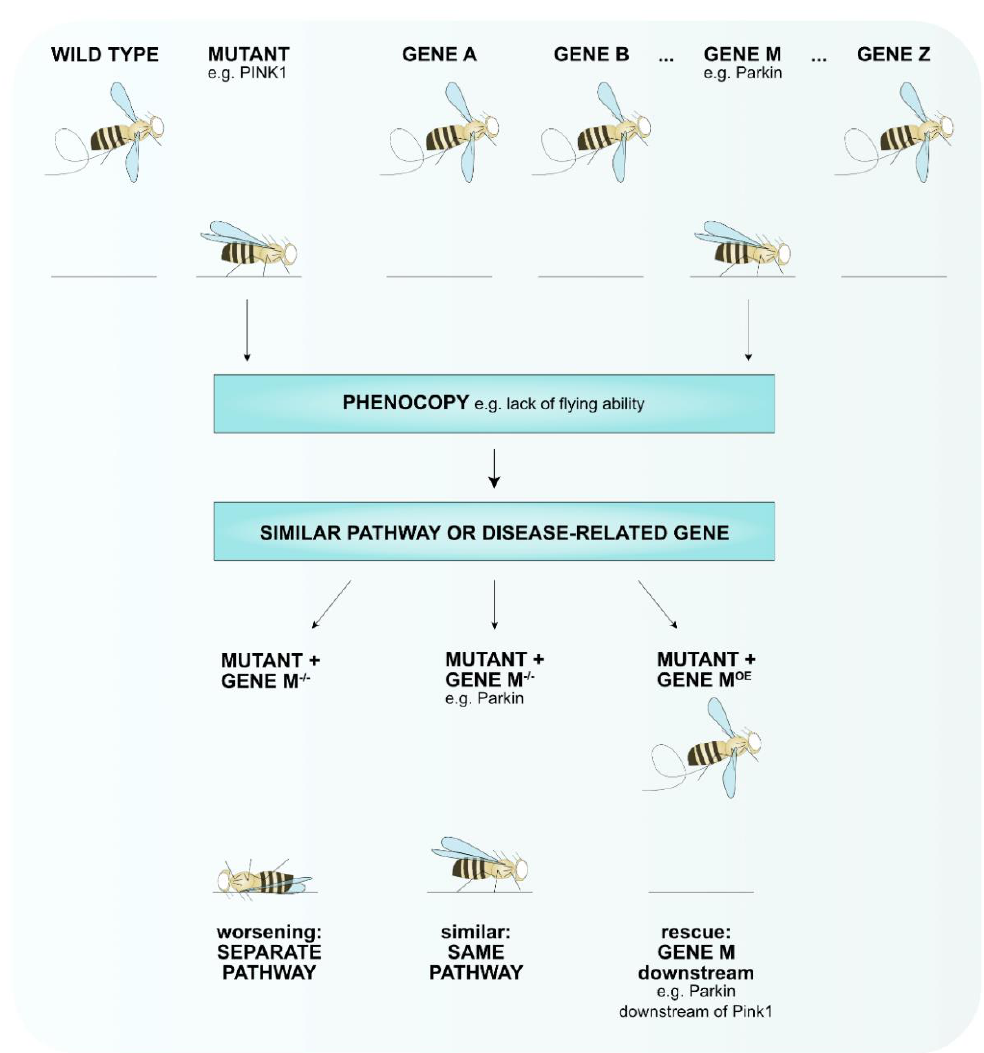
Figure 1. A phenotypic screen can identify novel genes involved in the disease pathway. A collection of mutant alleles (gene A–gene Z) can be used to identify genes that when mutated result in the same phenotype (phenocopy) e.g., lack of flying ability for pink1-mutant flies that are mimicked by parkin-mutant flies. To test if these genes function in the same pathway, the phenotypes of double-mutant flies can be tested. Loss of gene M worsens the phenotype of the disease mutant, thus, separate pathways play a role that converge into one. Loss of gene M does not enhance or improve the phenotype of the mutant meaning that these genes function in the same pathway (e.g., Pink1-Parkin). Overexpression (OE) of gene M rescues the mutant phenotype hints towards gene M functioning downstream of the mutant (e.g., Parkin functions downstream of Pink1).